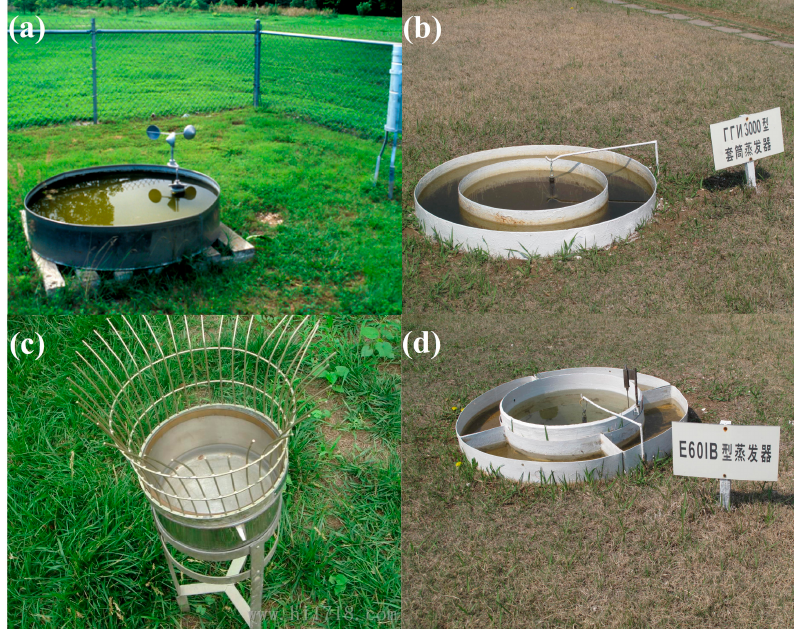
Figure 1. Four types of evaporation evaporimeters: Class A from the USA ( a ); GGI ‐ 3000 from Russia ( b ); and φ 20 ( c ) and E601B ( d ) from China. Table 1. Detailed information regarding the four types of evaporimeters.